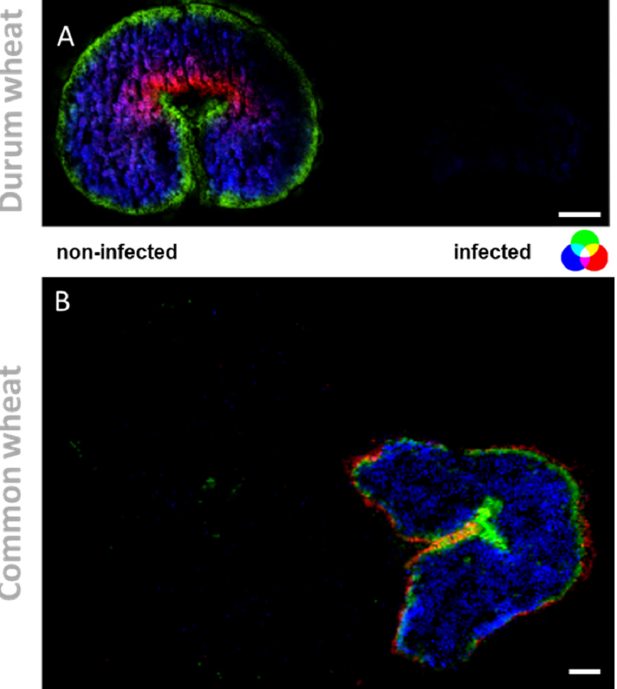
Figure 4. Tissue-specific changes, induced by mycotoxins accumulation in wheat kernels. ( A ) RGB overlay of m/z images of PE (37:1) m/z 798.5396 (red), DGDG (36:4) [M + K] + m/z 979.5735 (blue) and MGDG (34:1) [M + K] + m/z 795.383 (green). ( B ) RGB overlay of m/z images of coumaroylagmatine [M + H] + m/z 277.1659 (red), linoleic acid [M + K] + m/z 319.2033 (blue) and falcarindione [M + H] + m/z 257.1536 (green). MS images were generated with ( A ) 336 × 138 pixels; 20 µm pixel size; m/z bin width: ±5 ppm; scale bars: 500 µm; ( B ) 300 × 220 pixels; 15 µm pixel size; m/z bin width: ±5 ppm; images normalized to the total ion count on a 0–60% intensity scale; scale bars: 200 µm.